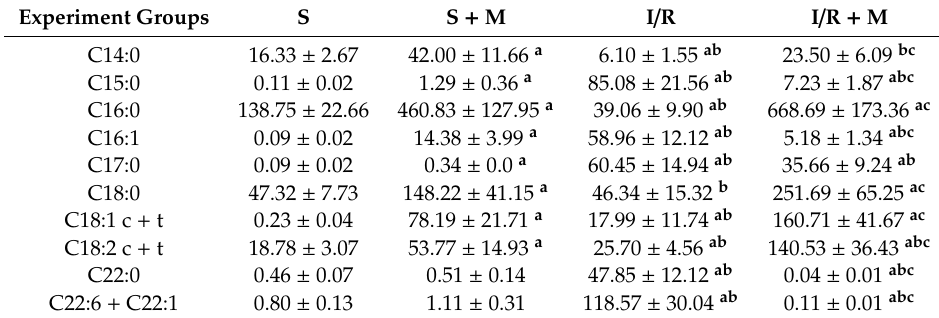
Table 4. Kidney fatty acid concentration ( µ g / g tissue). Group categories abbreviations: